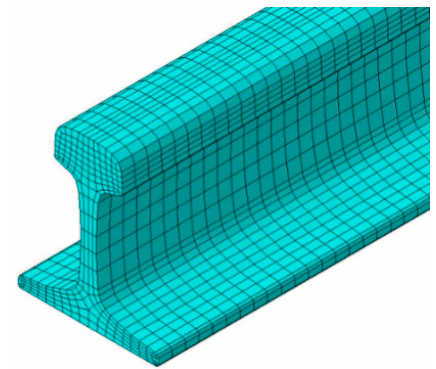
Figure 17. Finite element model of rail.